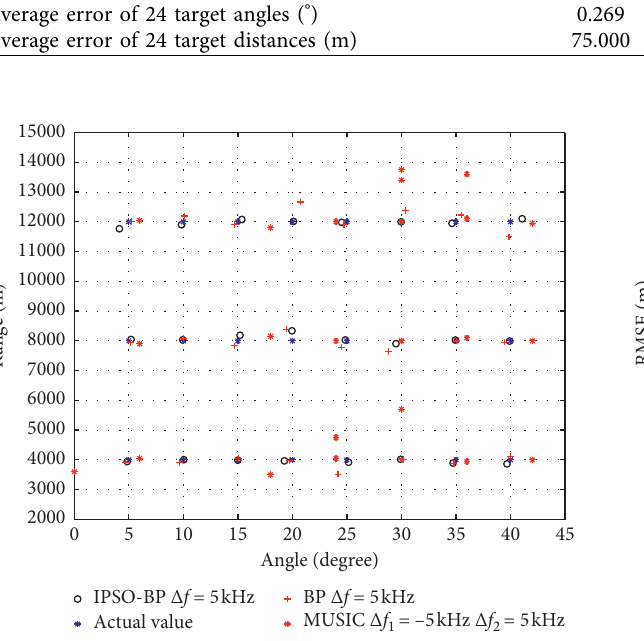
Figure 4: Target localization result of the three algorithms. Figure 6: RMSE of range estimation versus